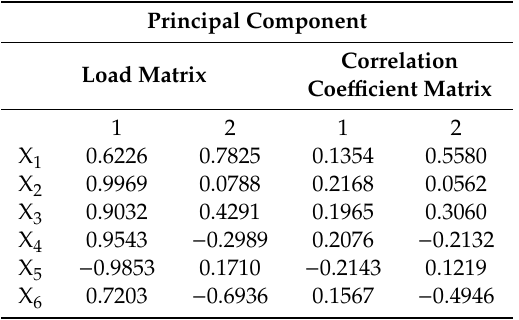
Table 7. The load matrix and correlation coe ffi cient matrix for principal component